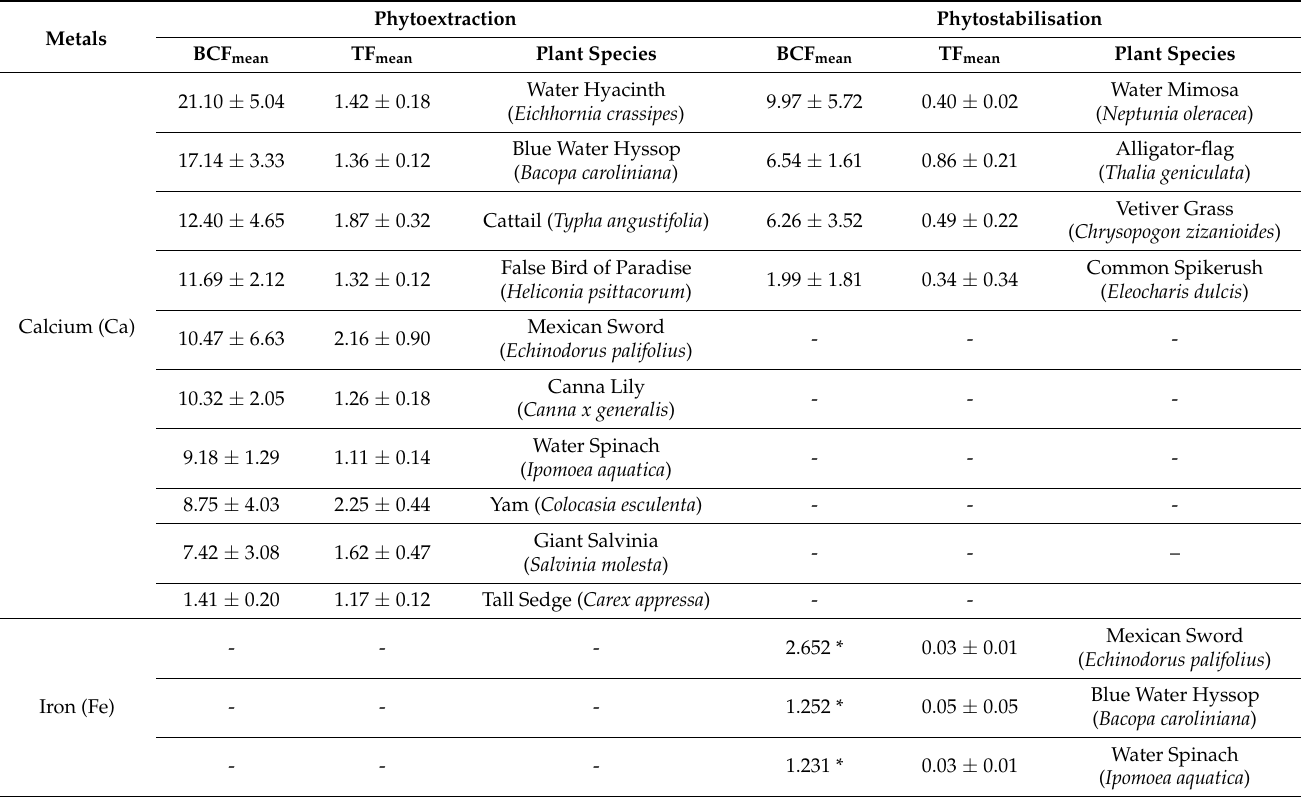
Table 4. Summary of plant species based on various types of phytoremediation